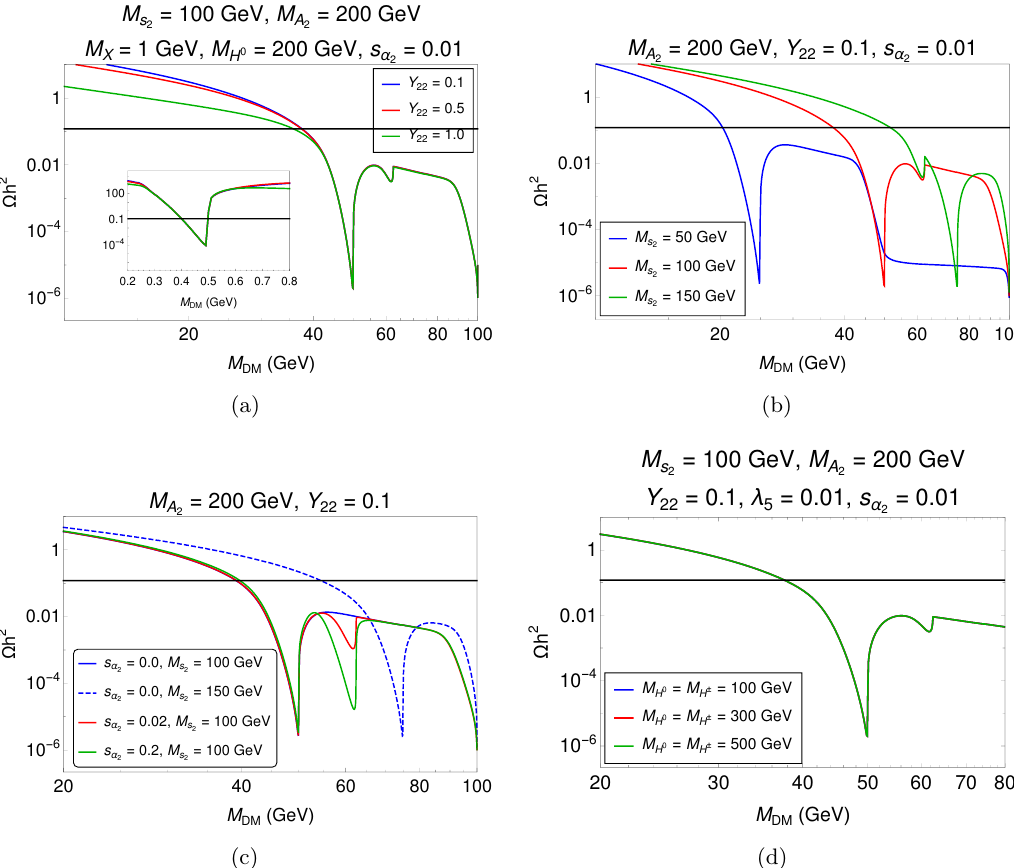
Figure 8 . Relic density vs dark matter mass (in GeV) for different values of Yukawa coupling Y 22 (8(a)), M s (8(b)), mixing angle s α (8(c)) and masses of inert scalars (8(d)). The solid black 2 2 line in each figure denotes the Planck observed relic abundance of DM. In figure 8(a) we have also shown the variation of the relic for sub-GeV masses of the DM in the inset.